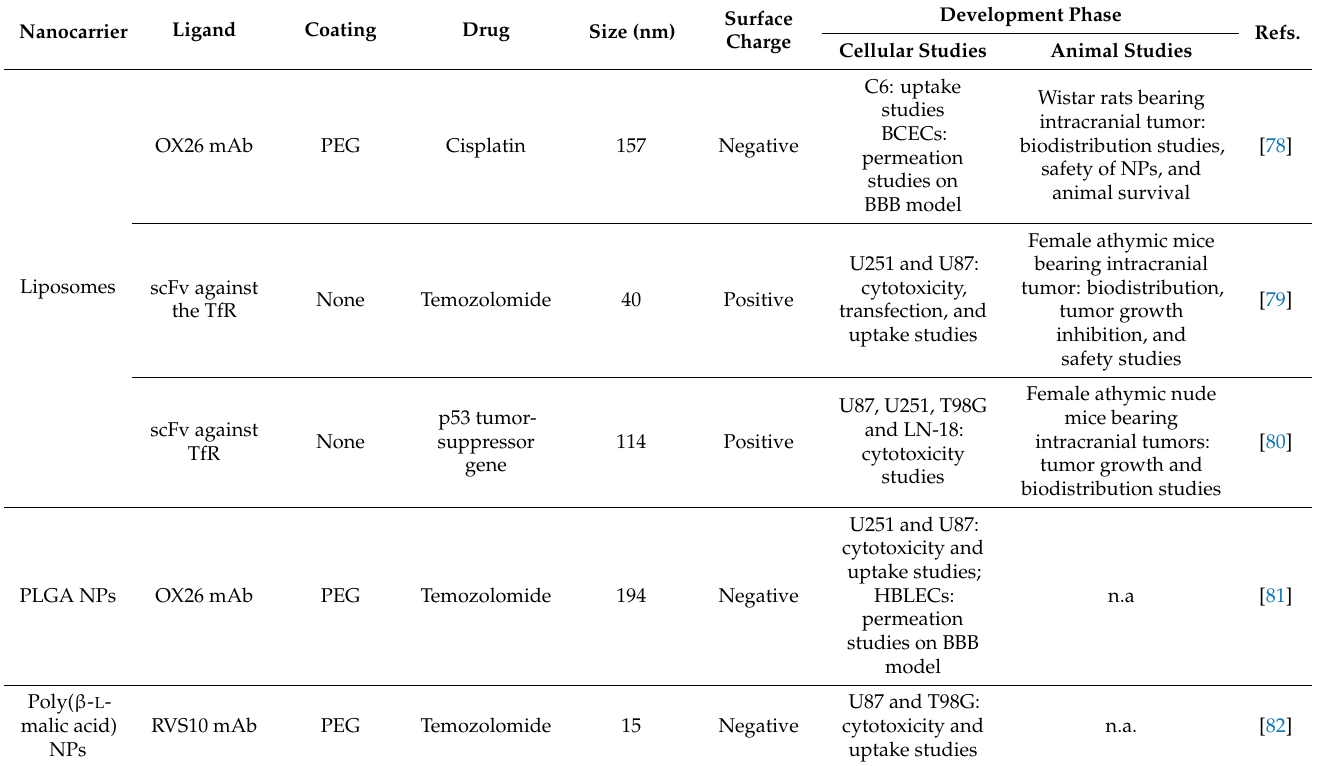
Table 3. Currently developed antibody-tailored nanosystems for GBM therapy (* mAb–monoclonal